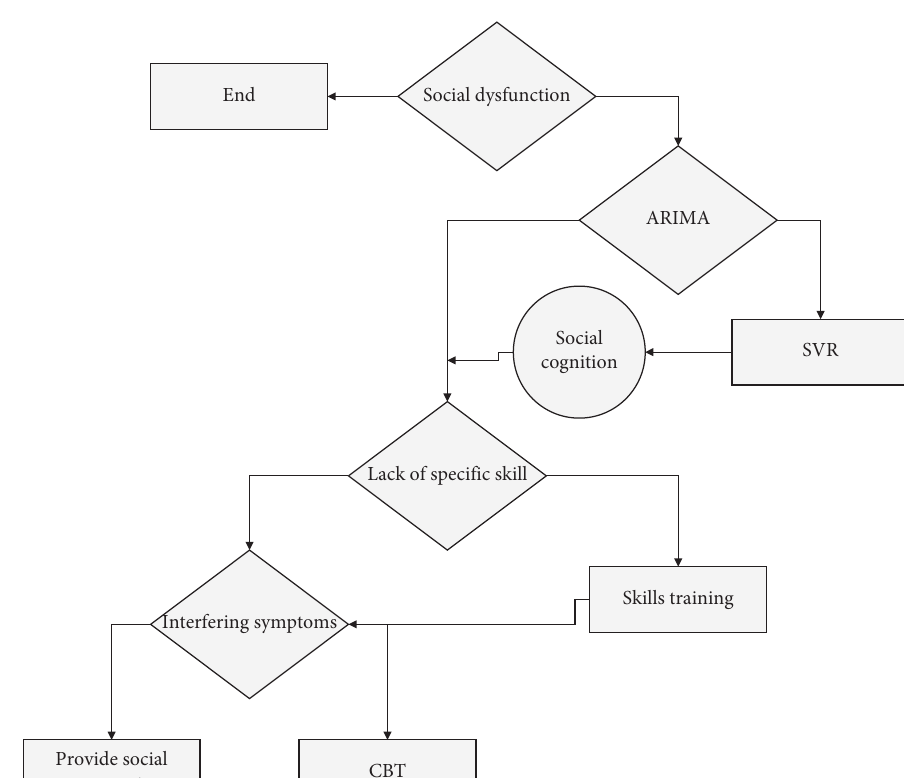
Figure 2: Nonlinear ARIMA model for feedback SVR.